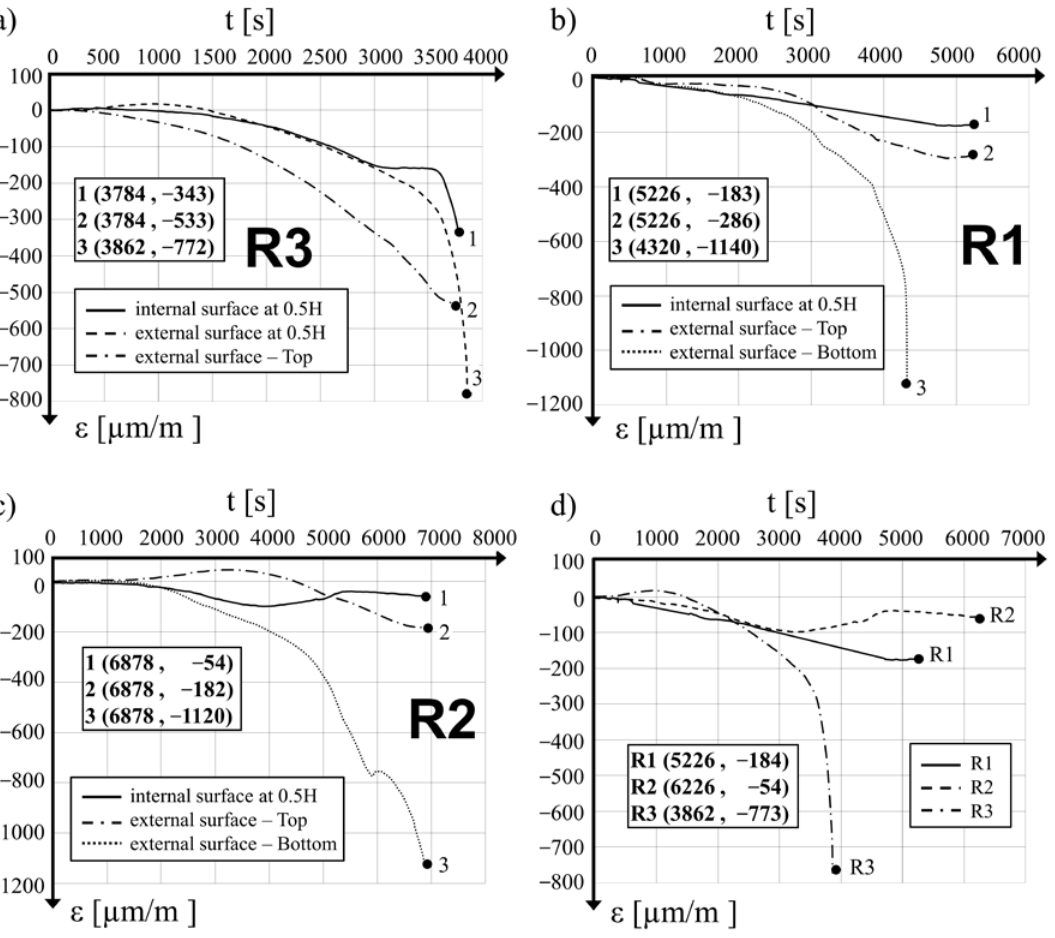
Figure 9. Development of circumferential average strains during the tests ( a ) for hollow cylinder R3, ( b ) for hollow cylinder R1, ( c ) for hollow cylinder R2, ( d ) at the internal surface of the three cylinders at their mid-height.